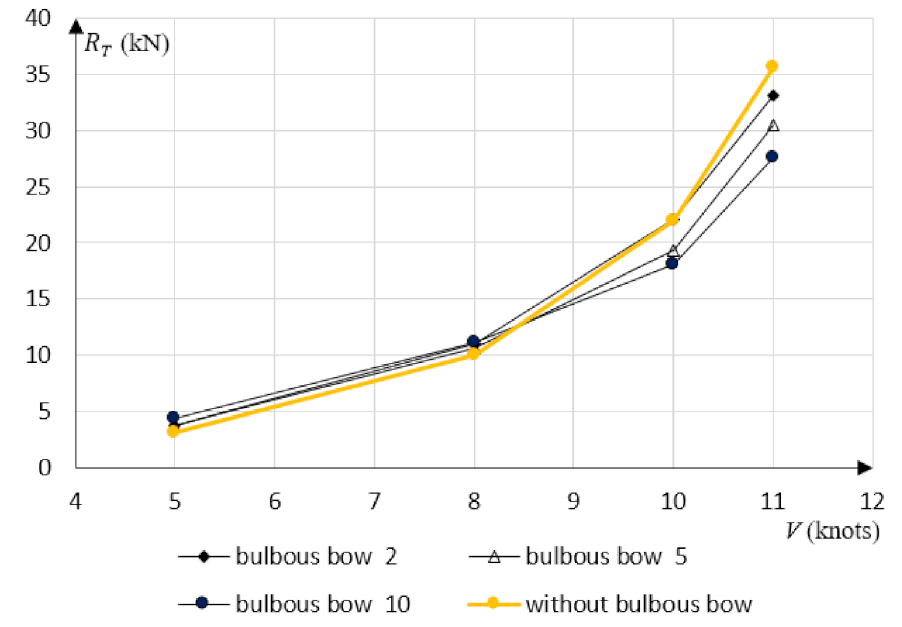
Figure 9. Resistance of a fishing vessel with added bulbous bow (three types of bulbous bows of various